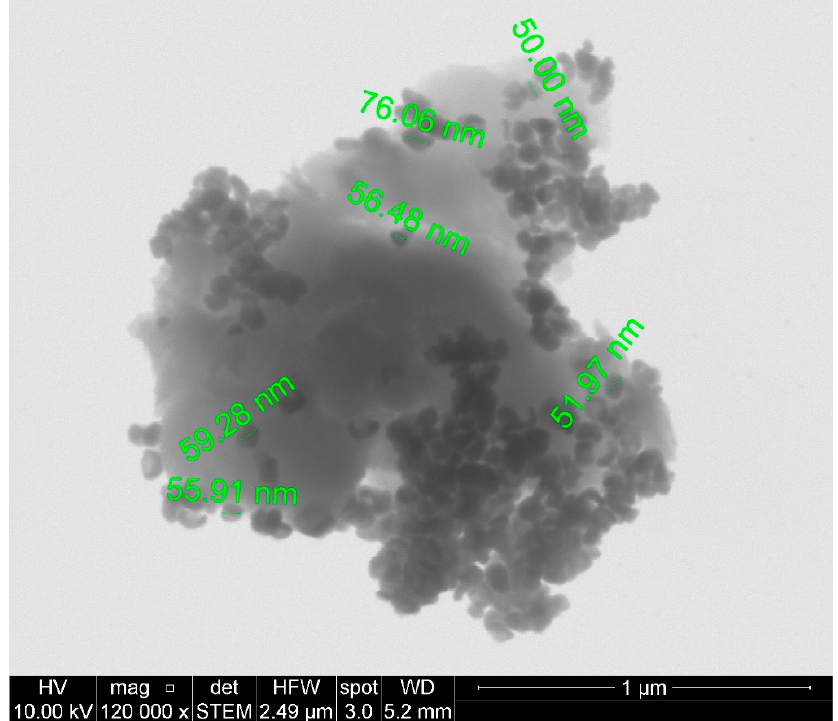
Figure 7. STEM image of GO-g-PMMI/BTN 120,000×, showing the presence of barium titanate nanoparticles on the surface of the GO-g-PMMI.